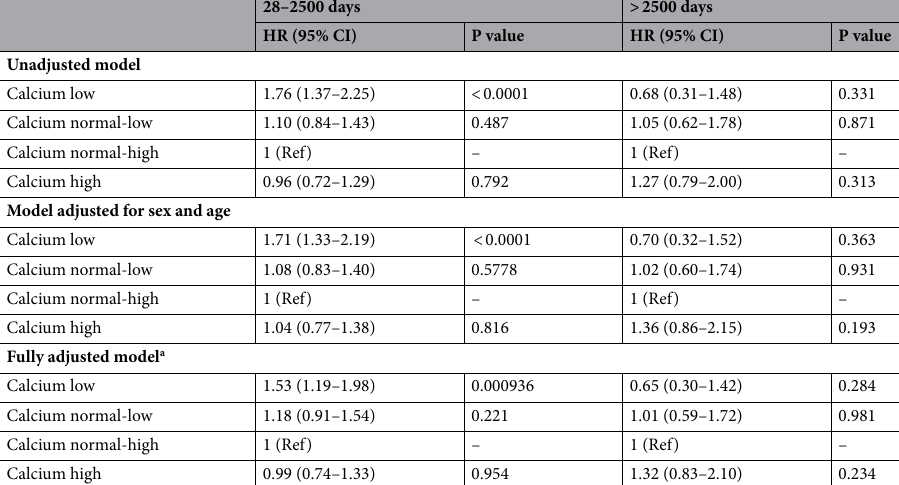
Table 2. COX-Regression models by calcium groups; an unadjusted model, a model adjusted for sex and age and a fully adjusted model. Two observational periods were distinguished: from 28 to 2500 days after incidental AMI and more than 2500 days after incidental AMI. a Adjusted for age, sex, renal function (eGFR), diabetes, hypertension, smoking status, hyperlipidemia, chest pain symptoms, STEMI/NSTEMI, any in-hospital complication, any intervention (PCI, bypass, lysis therapy), diuretics before AMI, calcium channels blockers before AMI, diuretics at discharge, calcium channels blockers at discharge, all four evidence-based medications